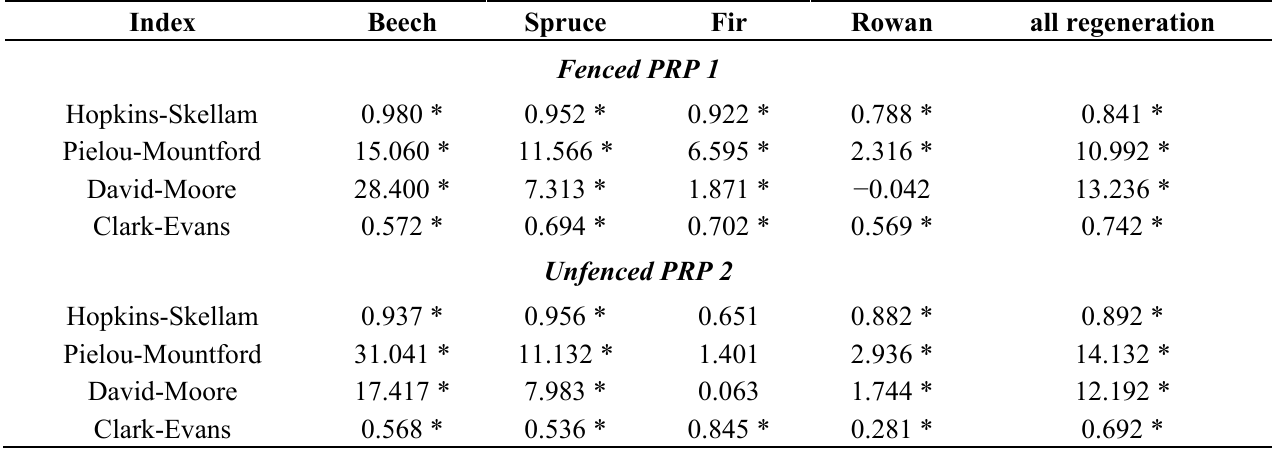
Table 3. Indices describing the horizontal structure of mixed spruce, fir and beech stands on PRPs 1 and 2.